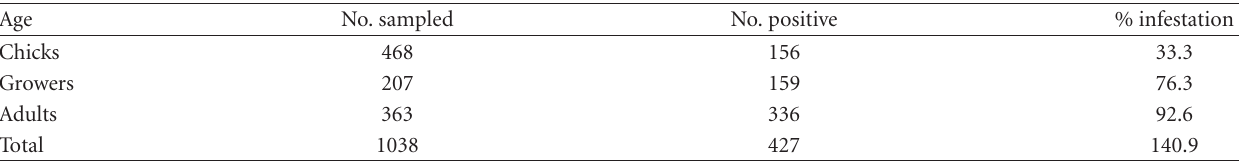
Table 1: Age distribution of ectoparasite infestation in the sample population.